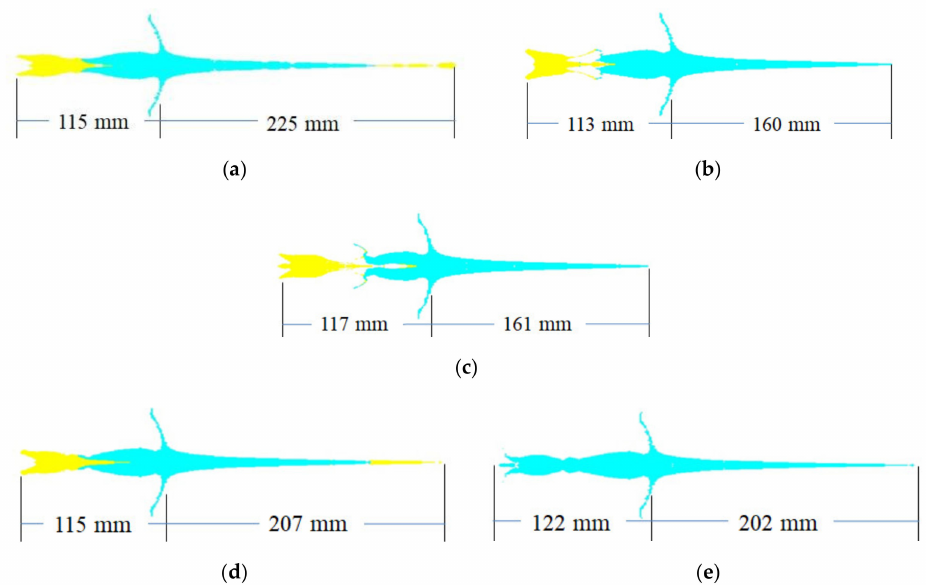
Figure 4. Projectiles of cylinder-cone-shaped charges at 50 µ s. ( a ) Cylindrical nickel liner. ( b ) Cylin- drical tungsten liner. ( c ) Cylindrical tantalum liner. ( d ) Cylindrical steel 4340 liner. ( e ) Cylindrical copper liner.